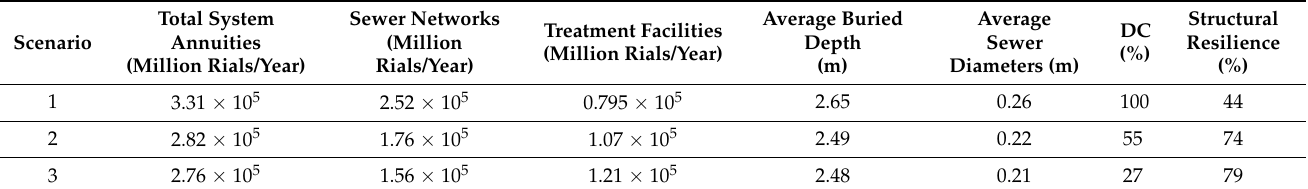
Table 4. Comparison between scenarios 1 and